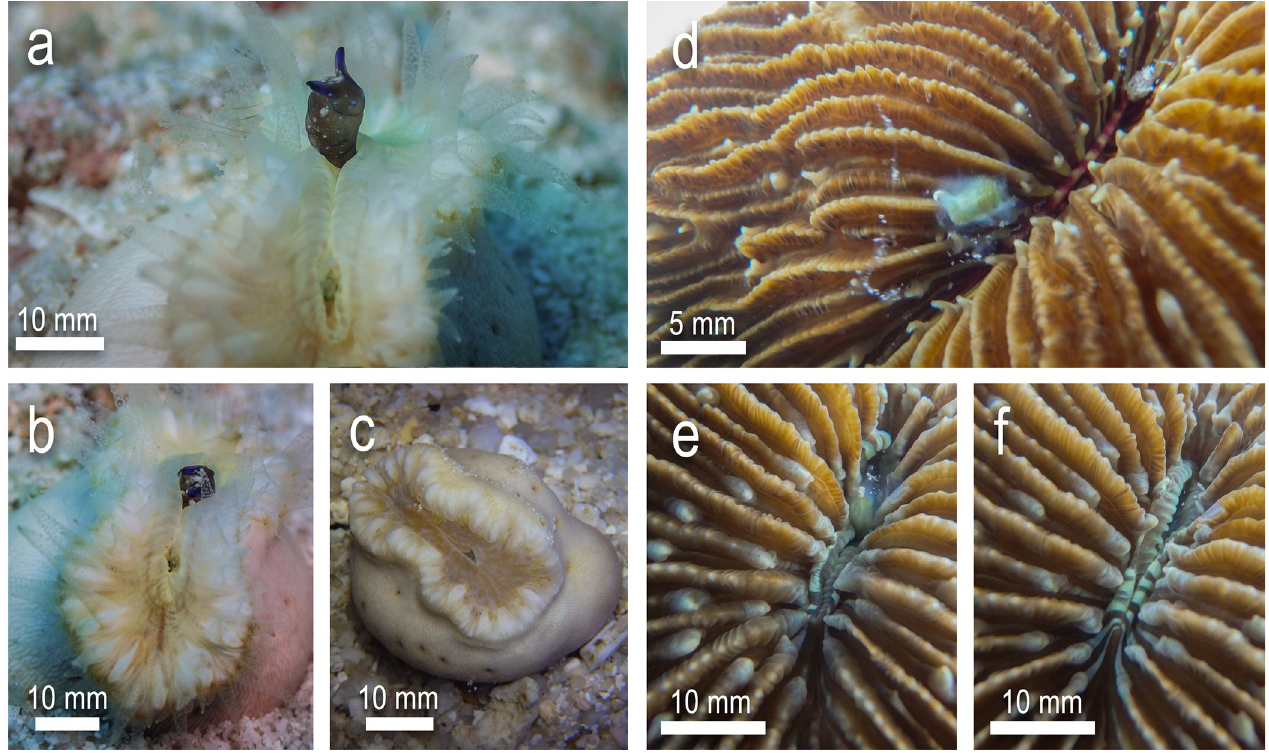
Fig 3. Ingestion of sacoglossan species Elysia cf. japonica by Heteropsammia cochlea (a-c) and Elysia pusilla by Fungia fungites (d–f).